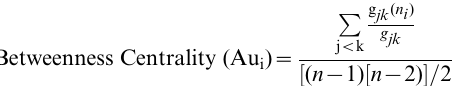
Top-10 papers in respect of centrality measures and their citation counts In respect of DegreeCentrality In respect of BetweennessCentrality PaperID.